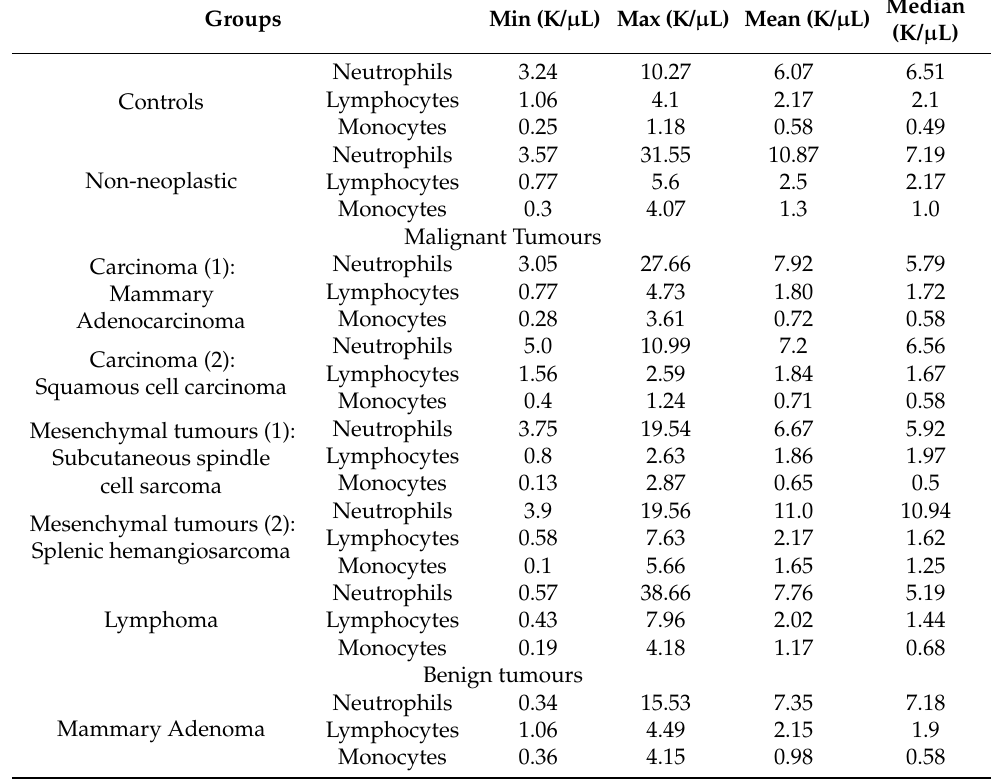
Table 4. Neutrophils, lymphocytes, and monocytes of dogs in this study.